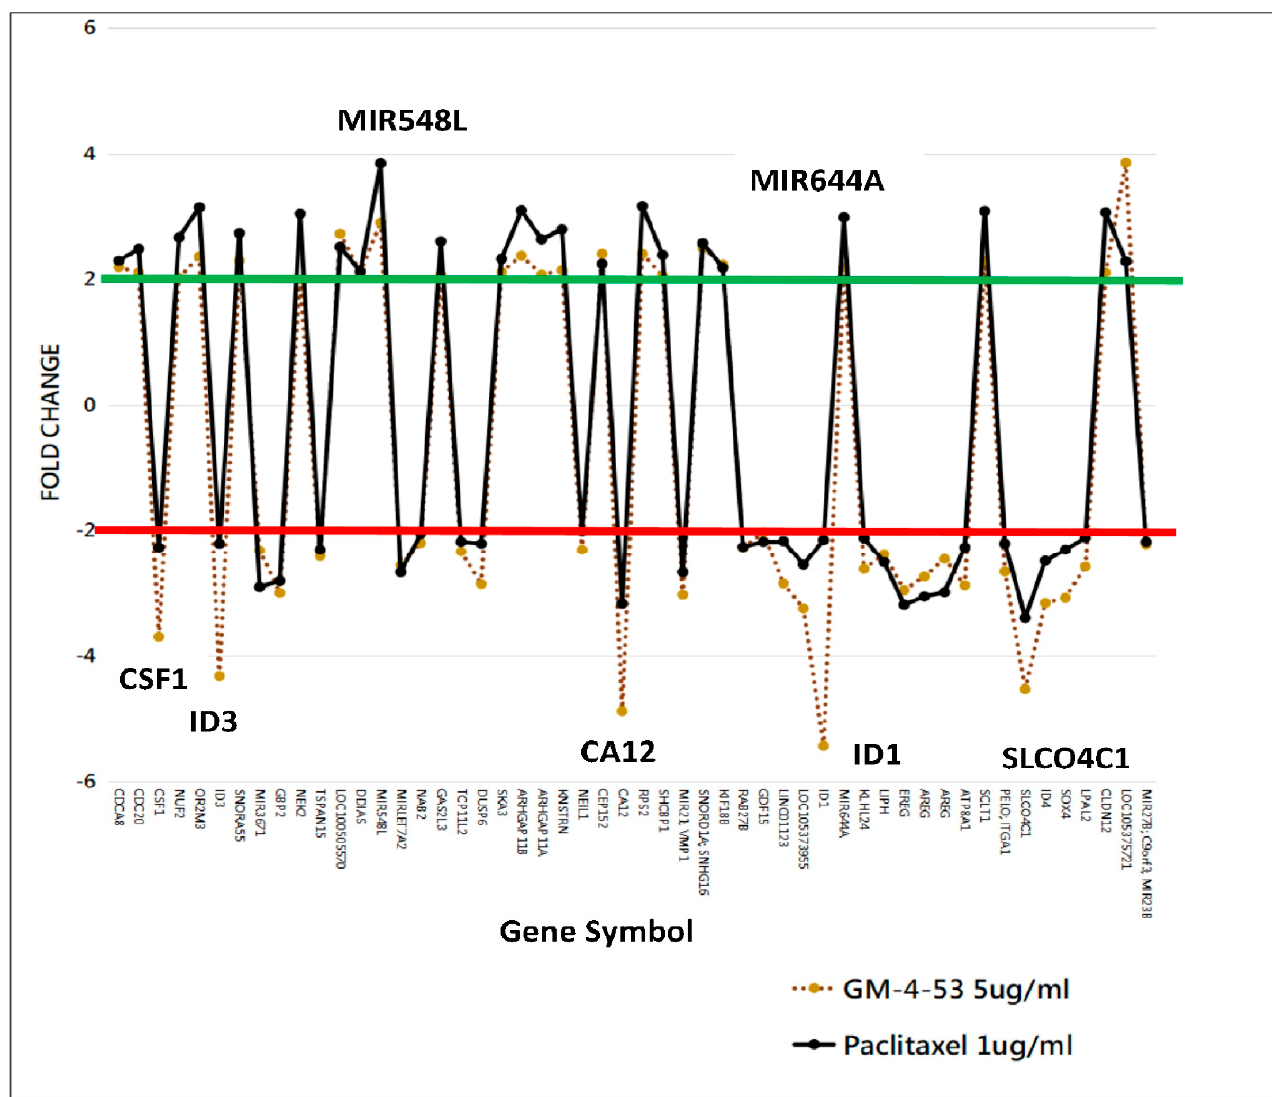
Figure 7. Overlapping DEG profile between GM-4-53 and paclitaxel. The data represent fold change for genes meeting the selection criteria = FC > 2 or < − 2, p -value < 0.05, and FDR p -value < 0.05.